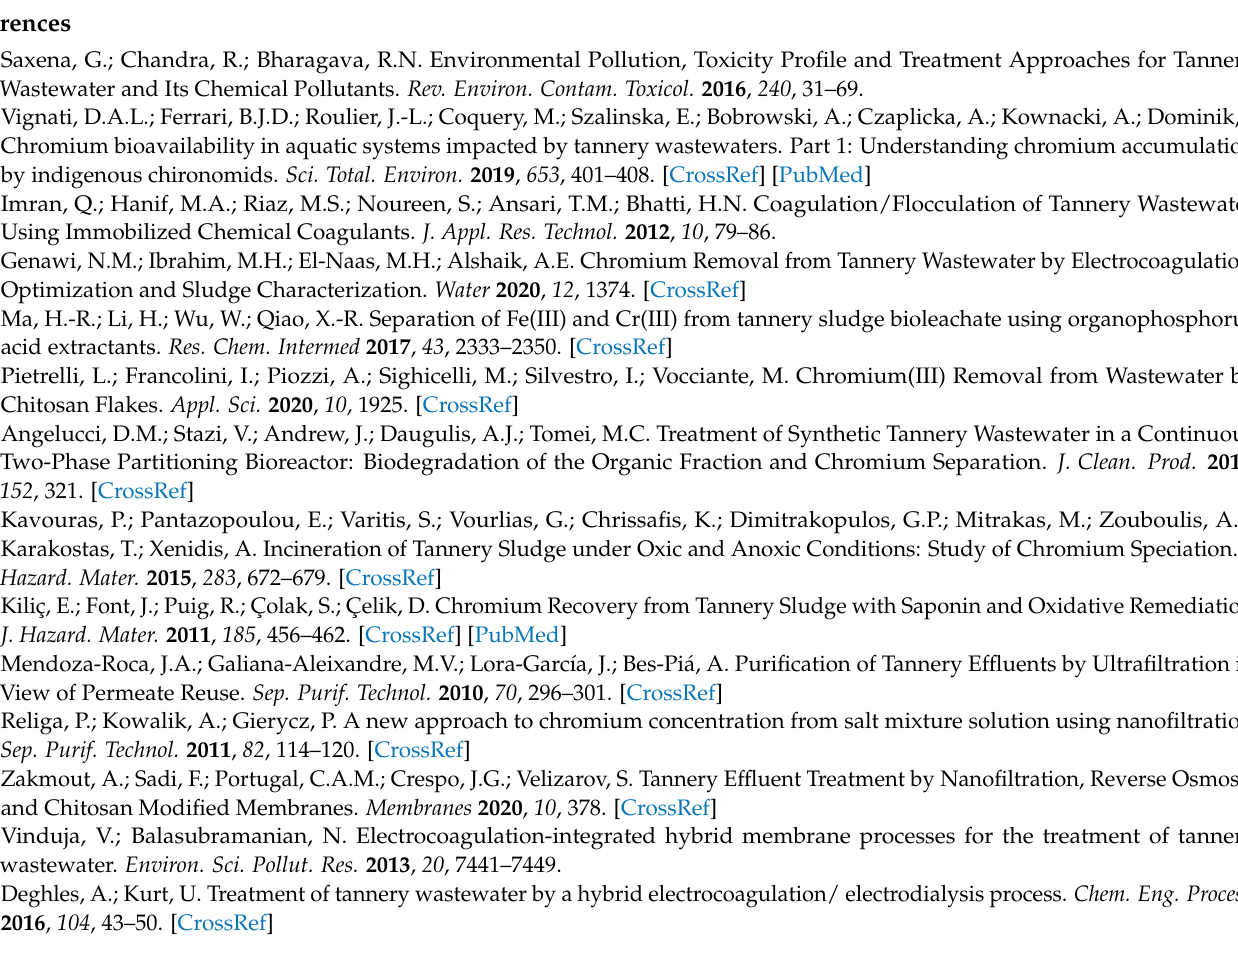
mode. Figure S2: Comparative analysis between the selective retention of Cr(III), in reference to other species, by the cs-PES MF022 membrane, during diafiltration of the SW30 concentrate of a synthetic and real tannery effluent at 20